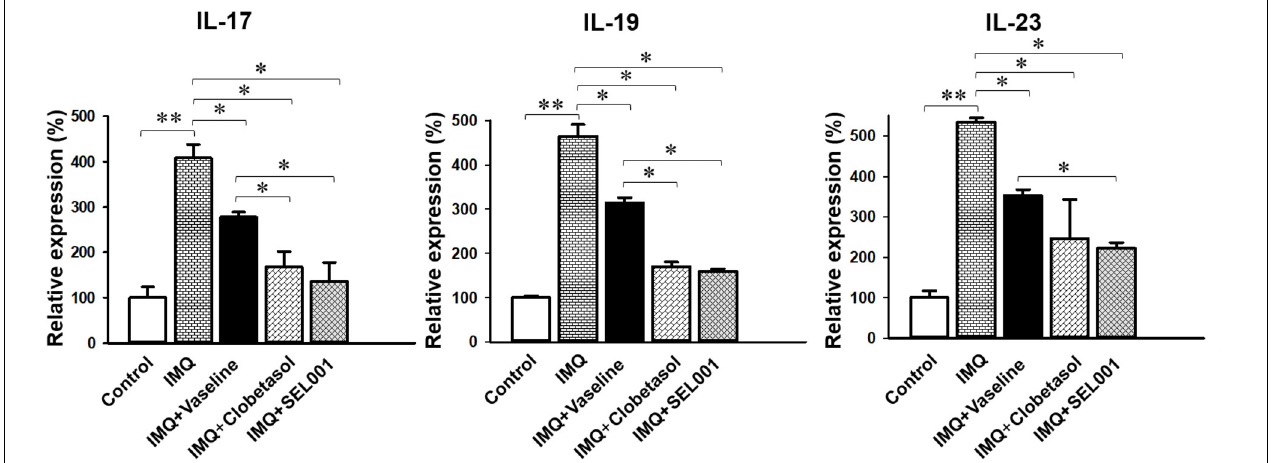
FIGURE 5 | mRNA expression profile. The data is expressed as mean ± standard deviation, ∗∗ p < 0.001 or ∗ p < 0.05 is significant, analyzed by one-way ANOVA